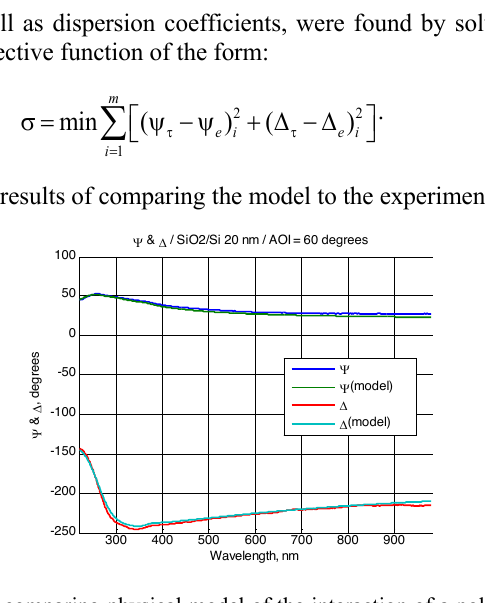
Fig. 2. The results of comparing physical model of the interaction of a polarized light beam with experimental data obtained from a layered SiO2/Si porous